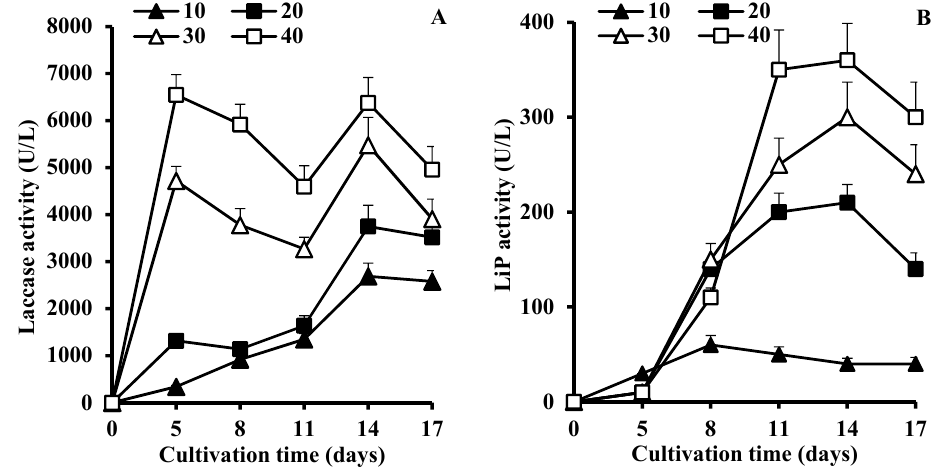
Figure 2. Profiles of laccase ( A ) and LiP ( B ) activities of C. gallica 142 in cultivation media supplemented with varied concentration of mandarin peels (g/L).